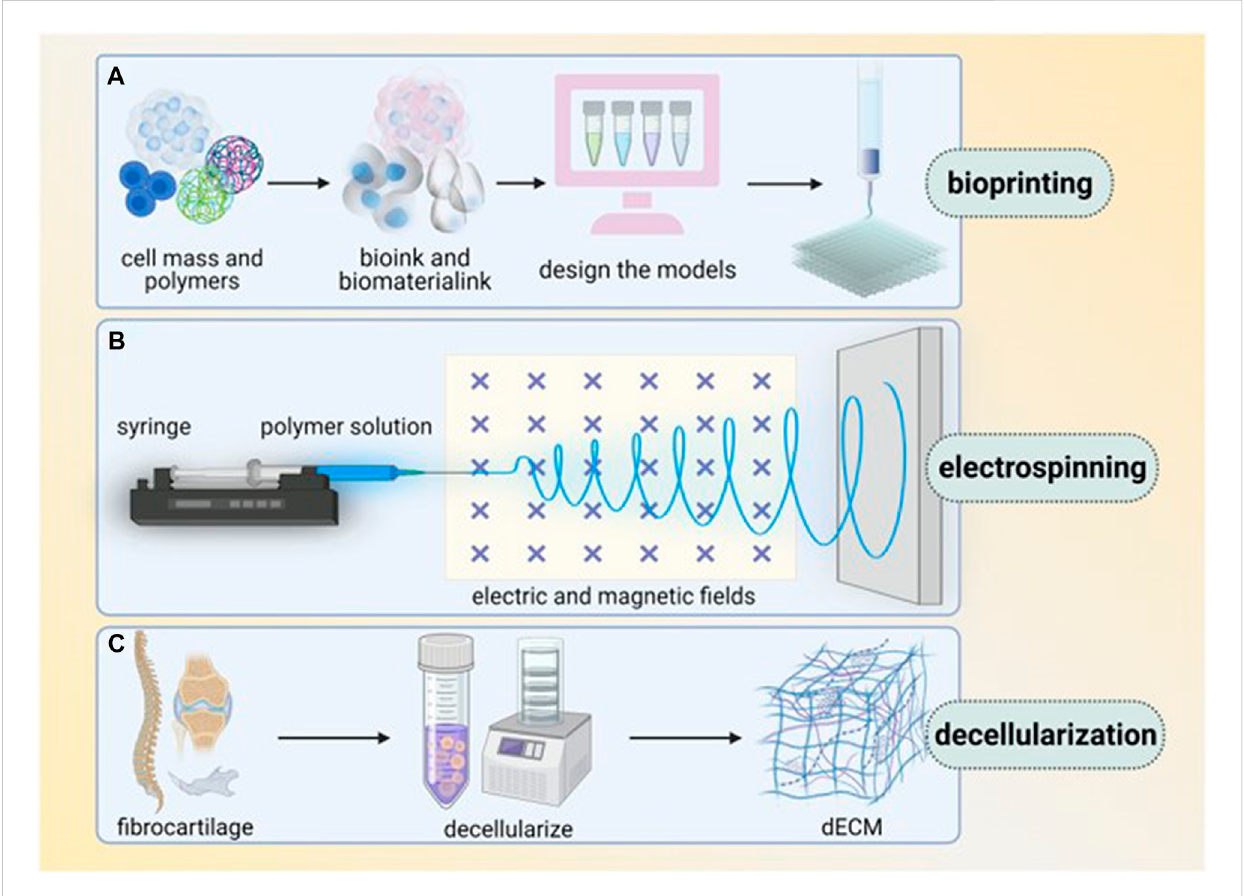
FIGURE 3 Main techniques of enthesis tissue engineering (several techniques are commonly used in enthesis engineering, including bioprinting, electrospinning and decellularization. (A) Bioprinting, in which bioink and biomaterial ink are extracted from cell mass and polymers, then models